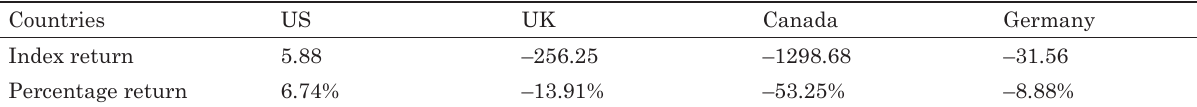
Table 5. The return of the securitized real estate indices of the four countries by holding one unit of each index throughout the whole period Countries